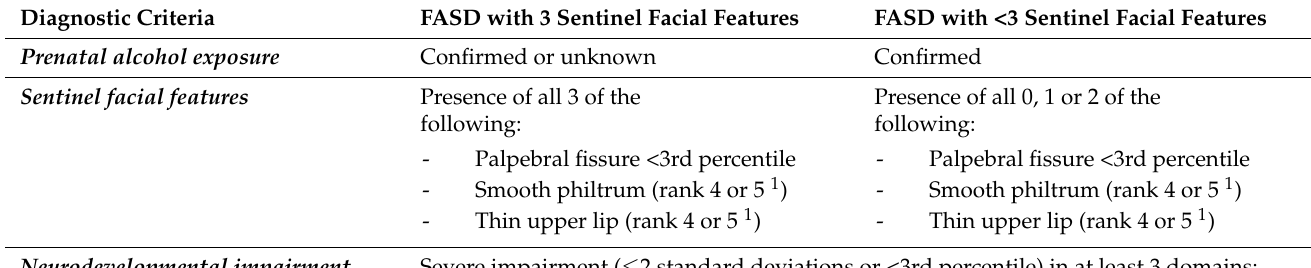
Table 1. Diagnostic criteria and categories for Fetal Alcohol Spectrum Disorder (FASD) according to The Australian Guide to the Diagnosis of